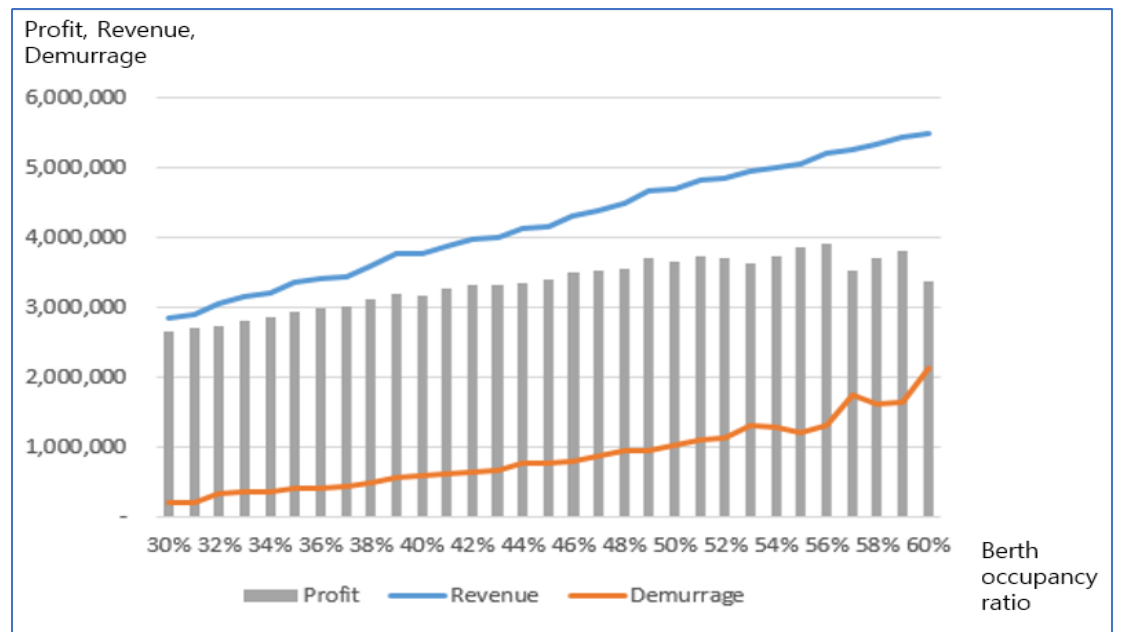
Figure 8. Dolphin profit and occupancy with USD 20,000 demurrage per day.